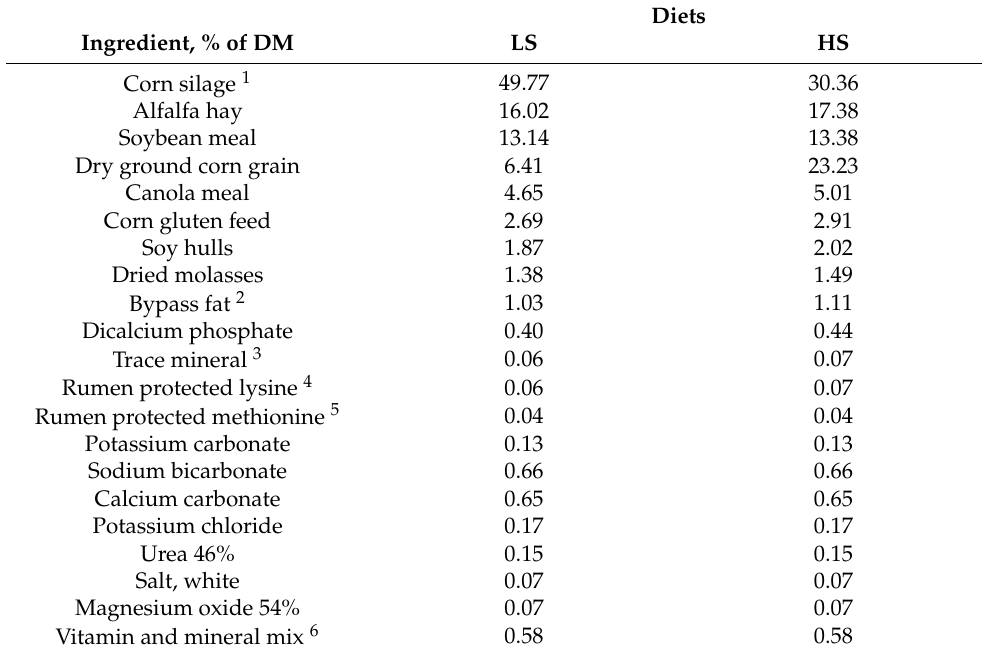
Table 1. Ingredient composition of the diets fed to lactating cows on a low-starch (LS) and high-starch (HS) diet during the experimental